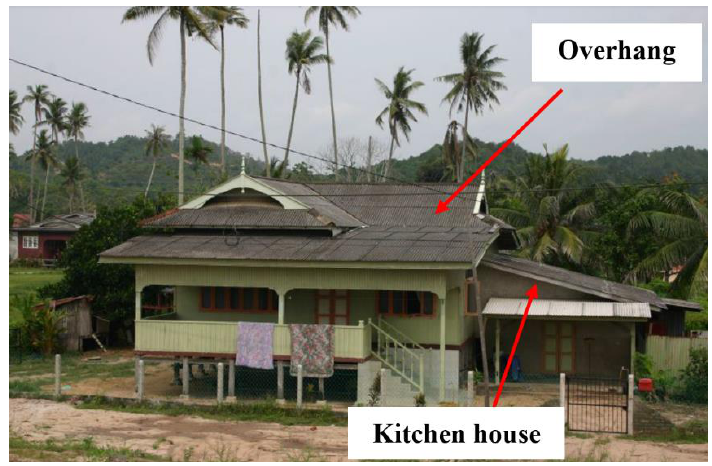
Figure 2. A typical rural house in Malaysia.